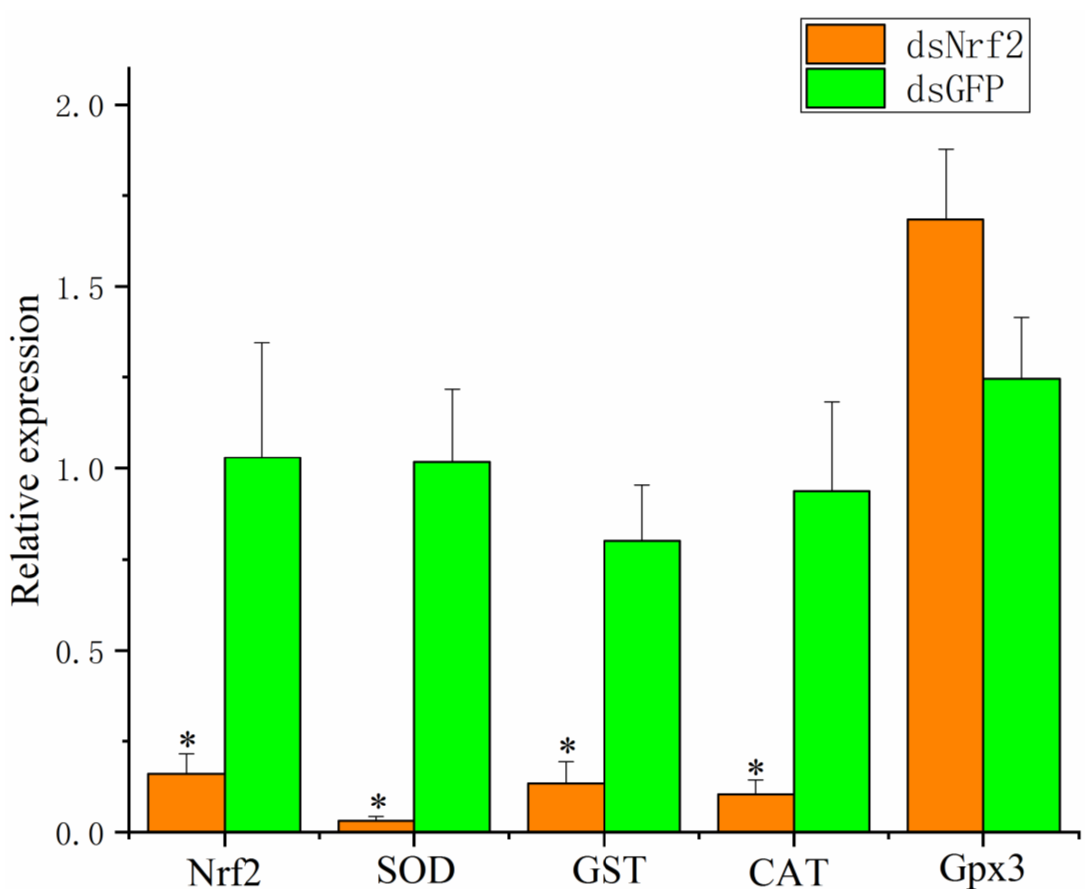
Figure 4. Expression levels of Nrf2, SOD, GST, CAT, and Gpx3 at 48 h after dsRNA injection. Values are expressed as the mean ± SD. Asterisks reflect significant differences between the dsNrf2 group and the dsGFP group (* p < 0.05).